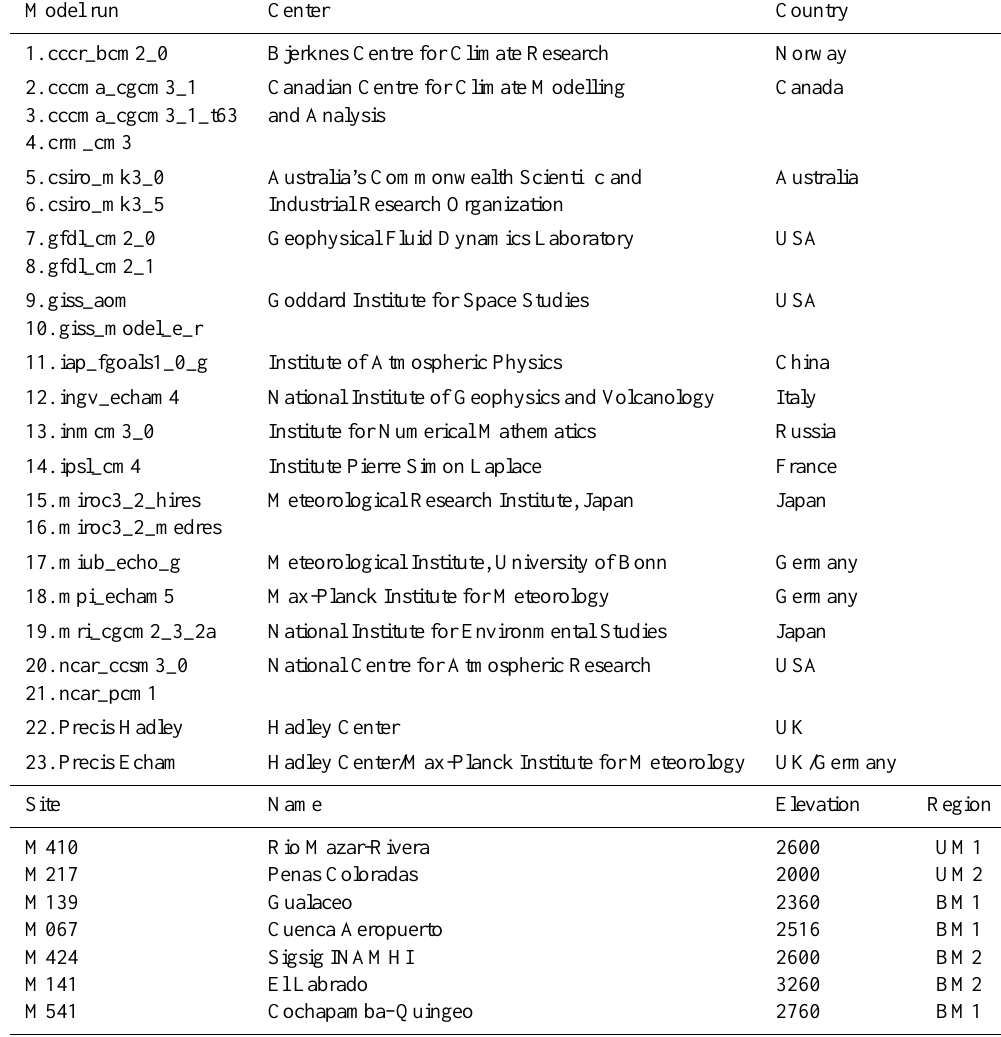
Table 1. GCM/RCM runs for the Ecuadorean region (top), and observed rainfall/temperature sites (bottom). Model